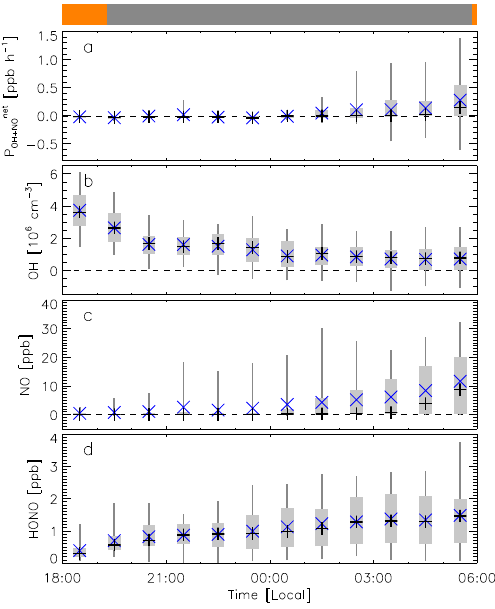
Fig. 5. Mean nocturnal variation of P net , OH, NO and HONO. OH + NO The color bar illustrates the local day (orange) and night (grey). These box-whisker diagram are based on 1h averages for time in- tervals where both measurements were present. The + refers to the median, boxes represent 50% (25% to 75%), the whiskers 90% of the data. The blue × is the